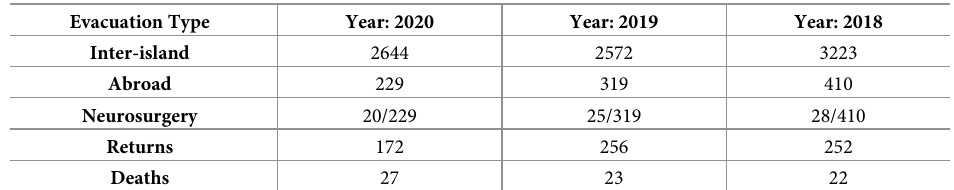
Table 2. Cape Verdean